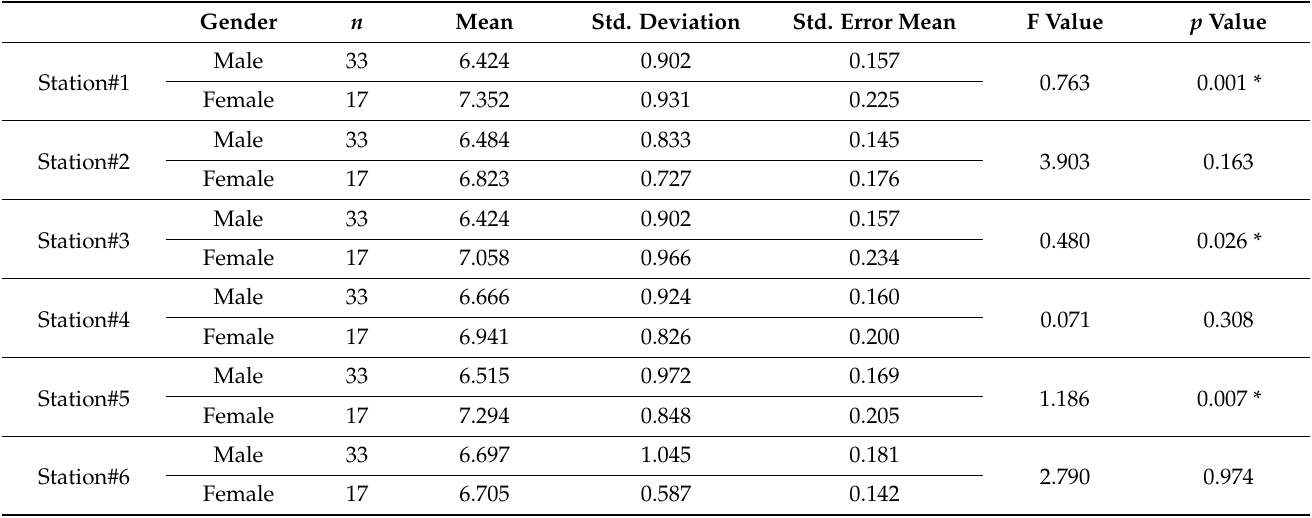
Table 2. Comparison of OSCE station scores with respect to gender (male and female).